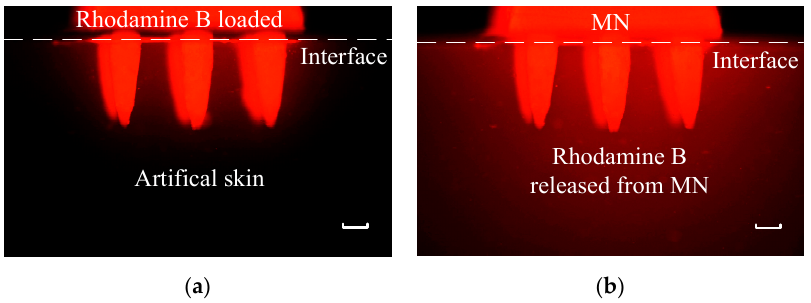
Figure 9. Fluorescence pictures of MNs with rhodamine B stuck into artificial skin without rhodamine B: ( a ) the moment MNs was stuck into artificial skin; ( b ) the MNs had been stuck into artificial skin for 1 h. The scale bar is 200 µm.